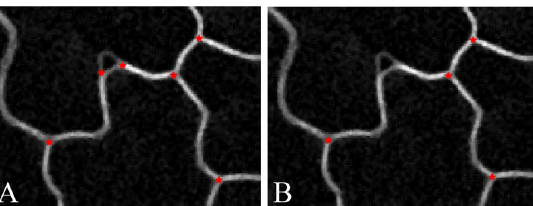
Figure 9. Example of computing 3 cell wall junctions from raw image ( A ), and ( B ) using our method.